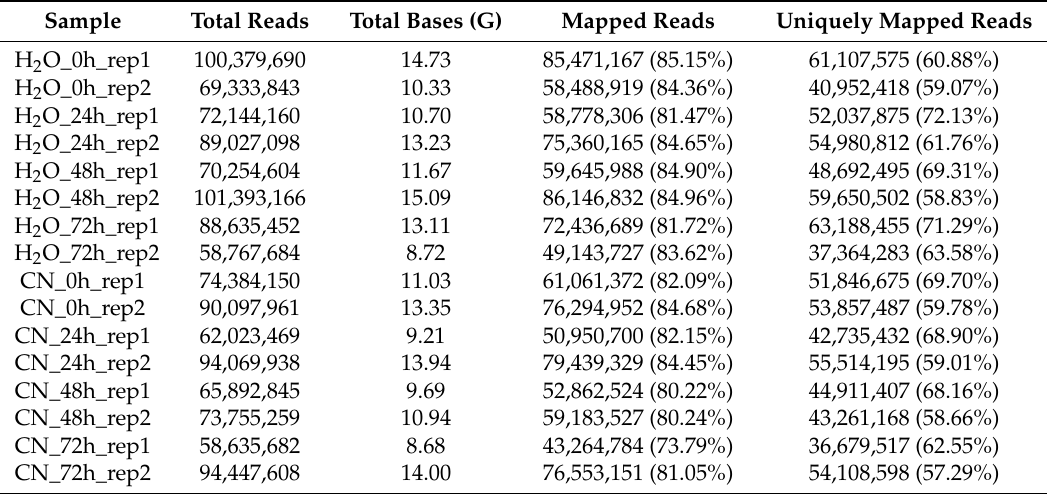
Table 1. Basic summary of sequence and sequencing reads mapping to the reference